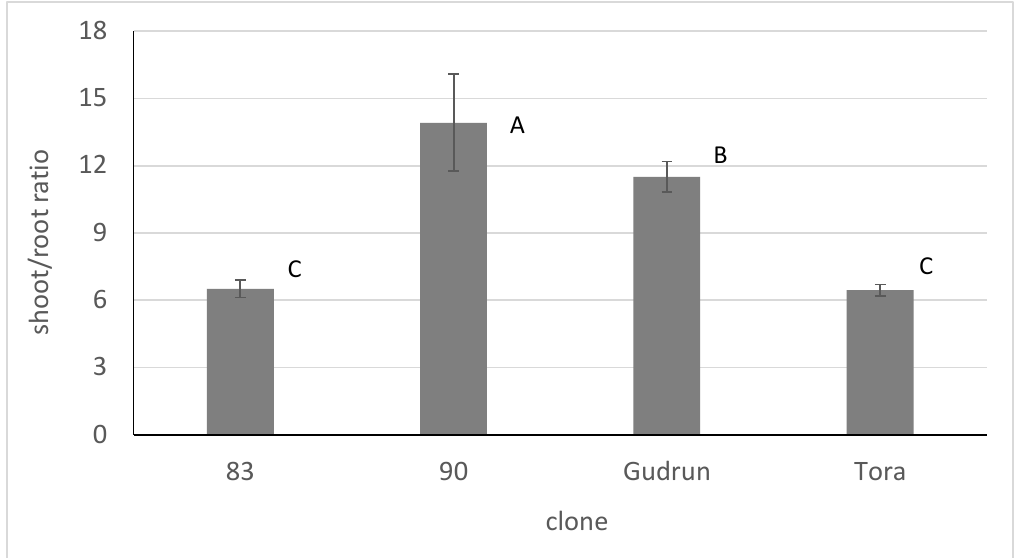
Figure 7. Relationship between the cutting diameter and number of visible buds on the cuttings of various clones in 2010 . 4. Discussion Our lab-scale experiment with Salix cuttings revealed that there are some patterns in the biomass production and allocation between roots and shoots that can be linked with studied factors. In general, hydroponic conditions differ from the natural growing environment by both unlimited water supply and more anaerobic conditions of rhizosphere. However, to our knowledge the studied Salix species in nature prefer wet growing conditions. Therefore we assume that both their roots and